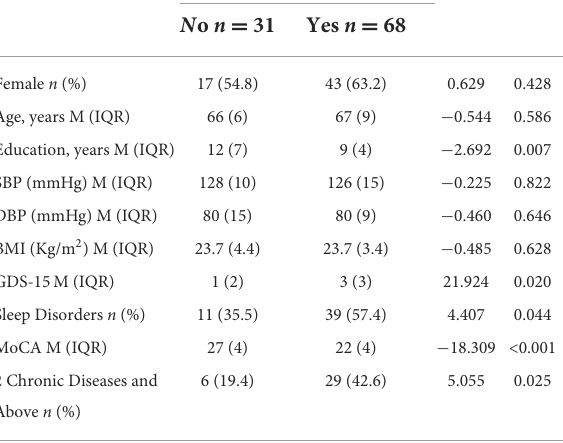
TABLE 3 Comparison of clinical characteristics between the two groups who completed wrist-wearable sensors monitoring ( n = 99). Variables